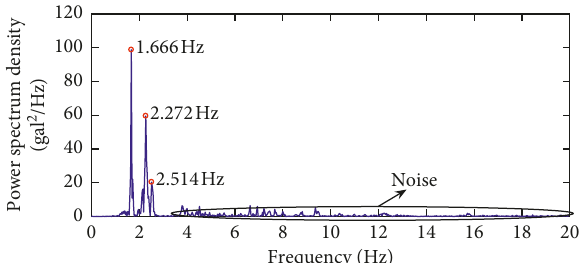
Figure 14: Spectrum diagram of the original signal.